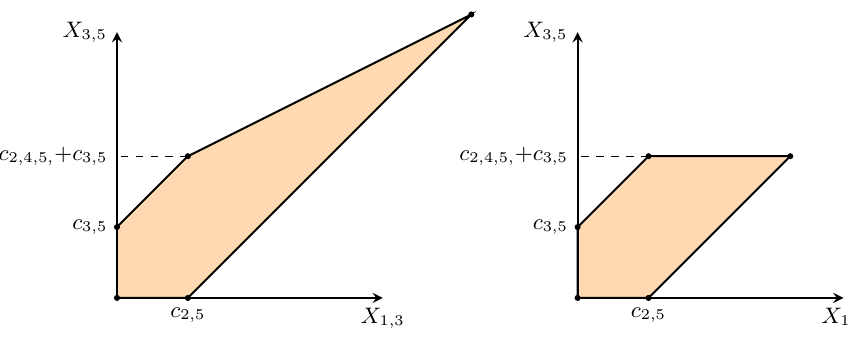
Figure 4 . The left geometry corresponds to the A 5 [1 , 2 , 3 , (4 , 5)] sub-amplitude that appears on the X 2 , 4 facet of A 6 [1 , (2 , 3) , 4 , (5 , 6)] . The right geometry is the geometry corresponding to A 5 [1 , 2 , 3 , (4 , 5)] derived from the inverse soft construction in section